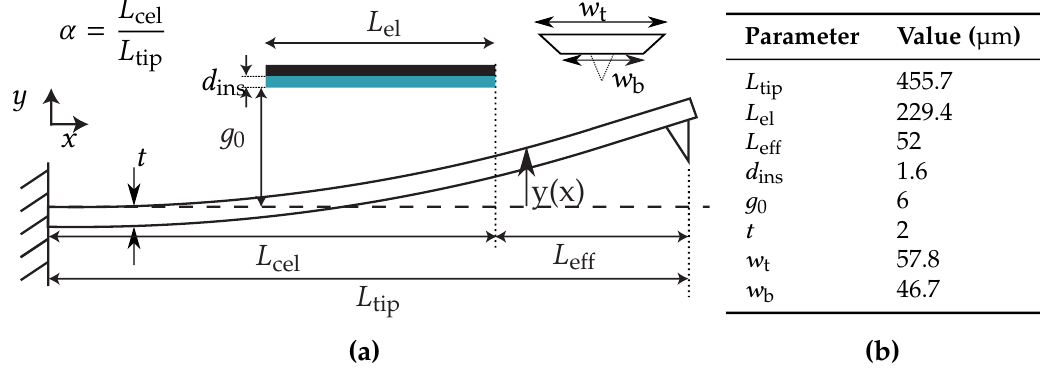
Figure 3. Schematic with the corresponding ( a ) geometry of the finite element model and ( b ) parameters used.